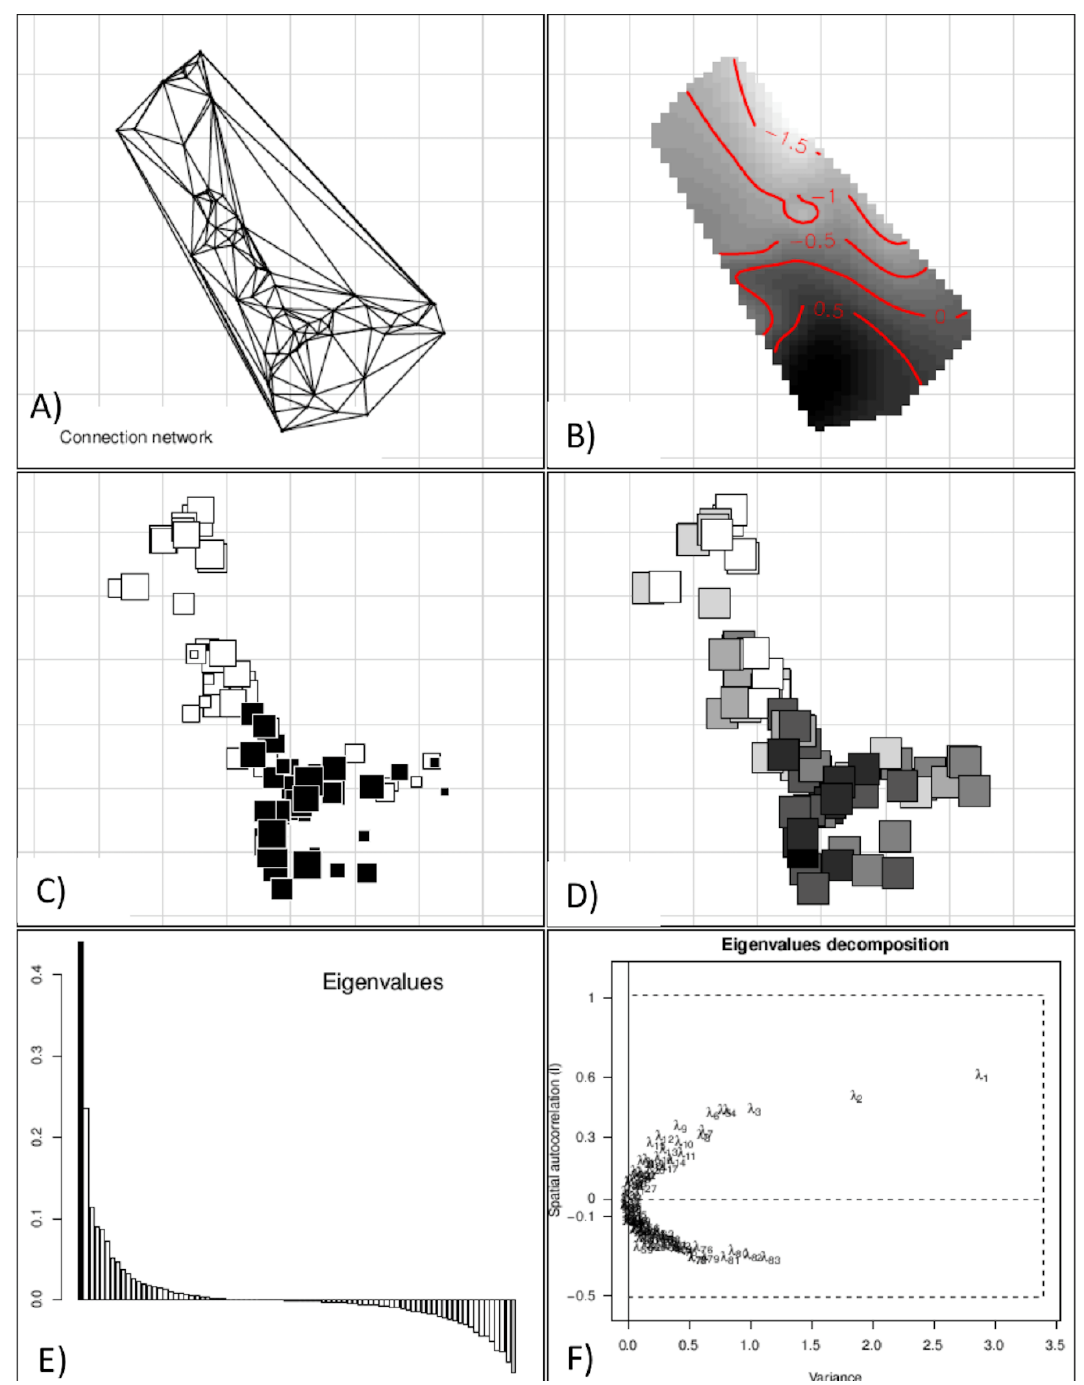
Figure A1.5 Spatial Principal Components Analysis of grizzly bear population structure for male bears conducted with a A) Delauney Connection Network and producing B-D) three representations of the first score and E-F) two eigenvalue